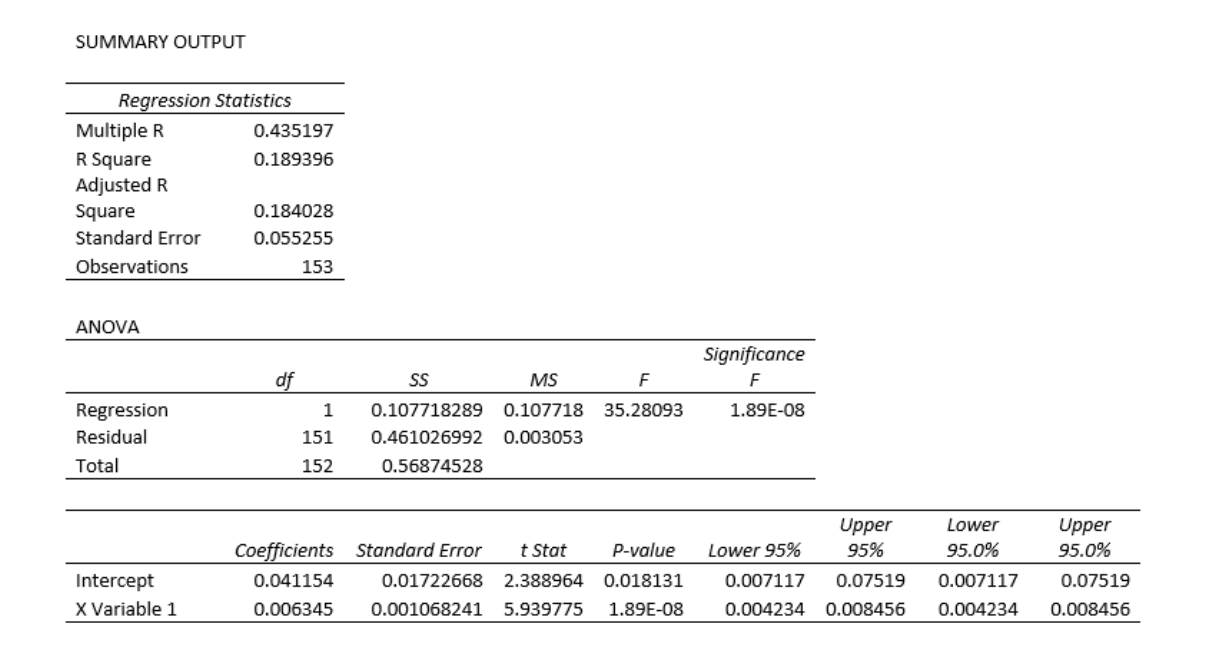
Figure 3. Analysis summary for chlorophyll prediction from river flow.